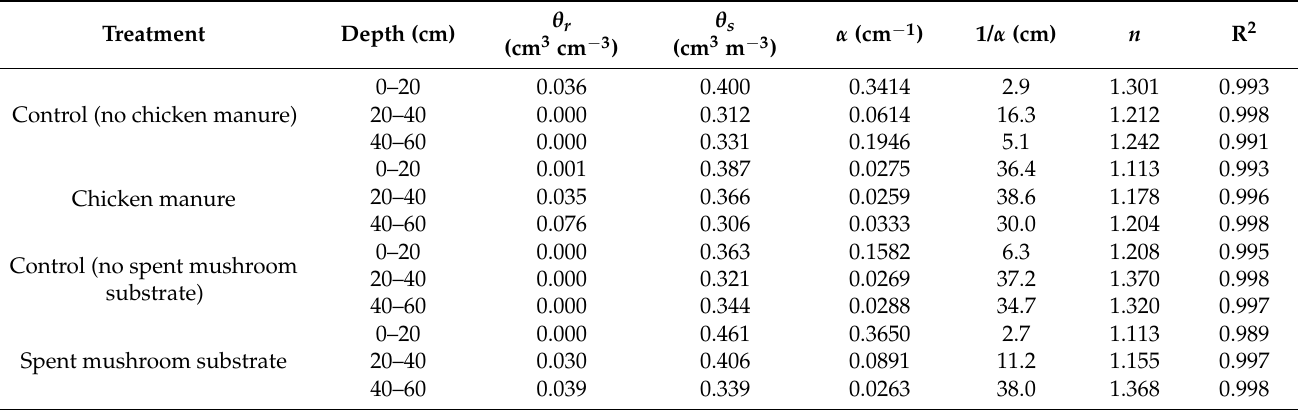
Table 2. Fitted values of the residual water content ( θ r ), saturated water content ( θ s ), scaling parameter ( α ), and shape parameter ( n ) of the soil water retention model (van Genuchten, 1980).